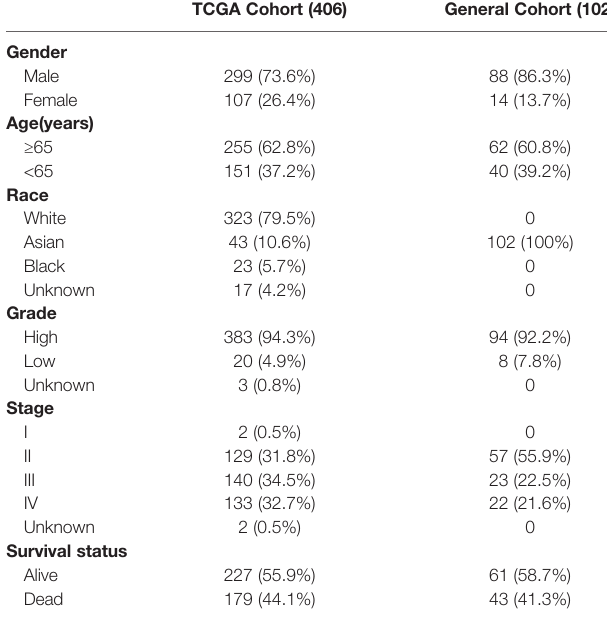
TABLE 1 | Basic clinical characteristics of patients in the TCGA cohort and General